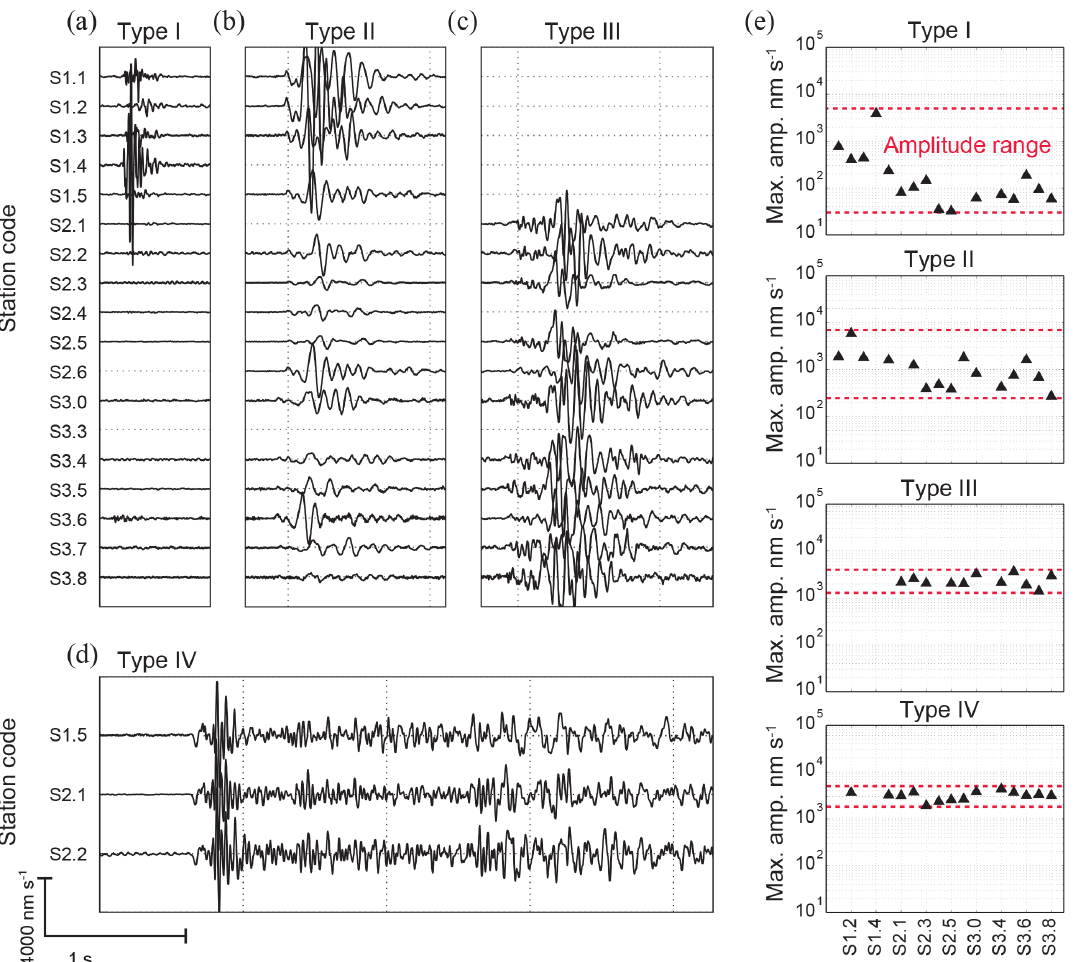
Figure 3. Vertical trace seismograms of quake events recorded at SZ10 (see station location and nomenclature in Fig. 1; empty traces correspond to missing or corrupted records). A constant amplitude and timescale are applied to all waveforms (bottom left). (a) Near high- frequency quake type I (29 May 2010, 23:05:05CEST). (b) Near low-frequency quake type II (26 June 2010, 18:44:55). (c) Moderate distance quake type III (17 June 2010, 15:32:45). (d) Local microearthquake type IV (7 June 2010, 11:24:29). Note the highly coherent successive phases and moderate scattering. (e) Maximum amplitudes (lognms − 1 ) recorded at individual stations for the four events displayed in (a) – (d) . Large amplitude ranges (i.e., important waveform amplitude attenuation, indicated by dashed red lines) enable one to discriminate event types I and II from event types III and IV which typically feature narrow amplitude